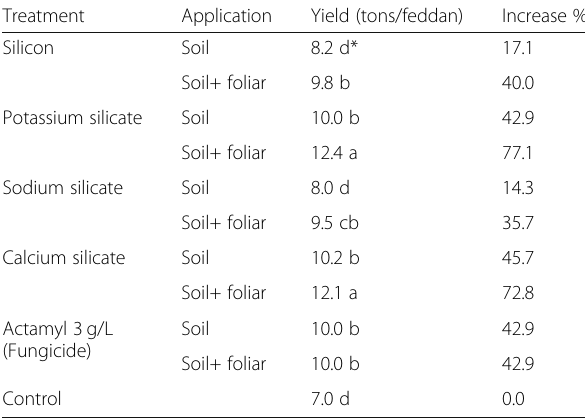
*Figures with the same letter are not significantly ( P ≤ 0.05) different